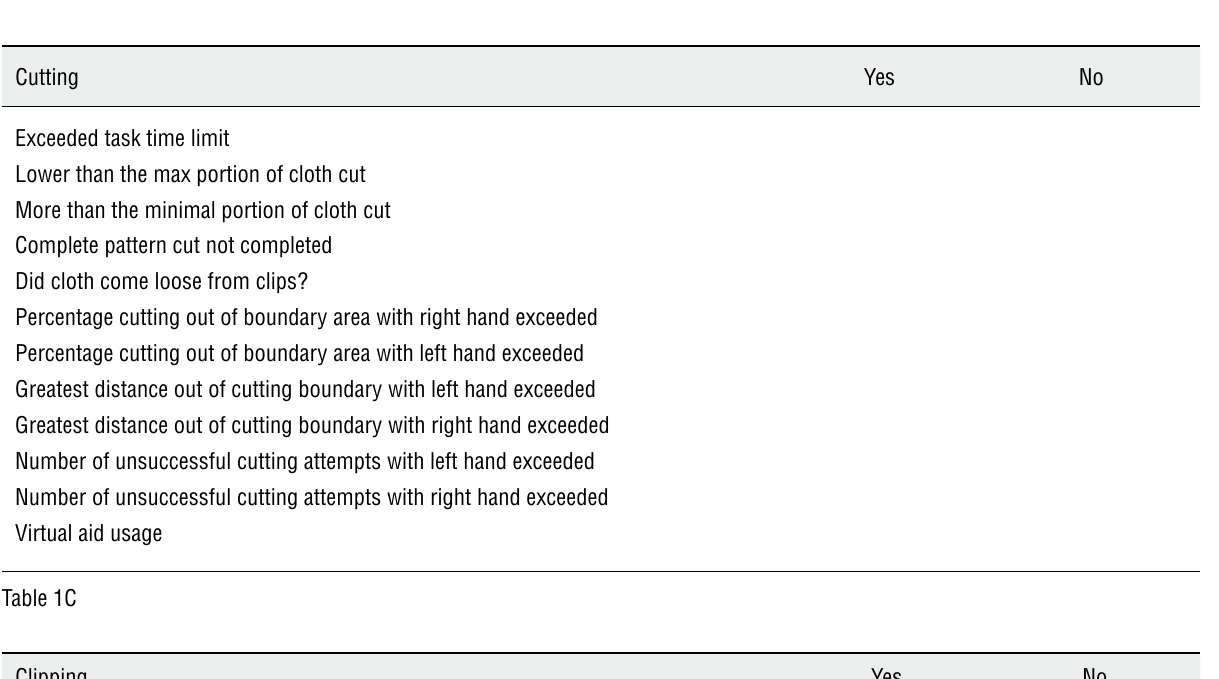
Clipping Yes No Time to complete task exceeded Total left hand path exceeded Total right hand path exceeded Blood loss Dropped clips left hand exceeded Dropped clips right hand exceeded Vessel perforated? Duct ligated or perforated? Clips placed too close? Maximum vessel stretch exceeded Clips applied in marked areas Correct number of clips placed in the marked area with left hand Correct number of clips placed in the marked area with right hand Misplaced clips left hand Misplaced clips right hand Cutting in the marked area Virtual assistance